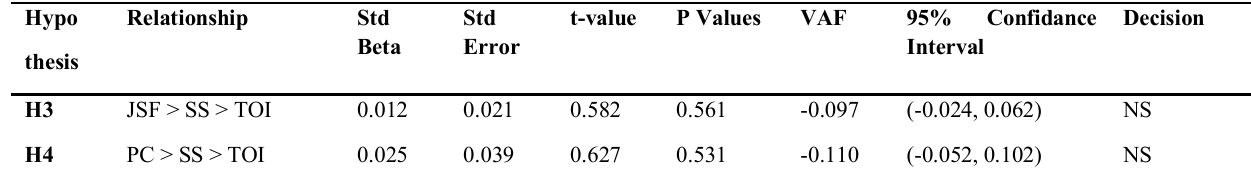
Table 6: Mediation analysis